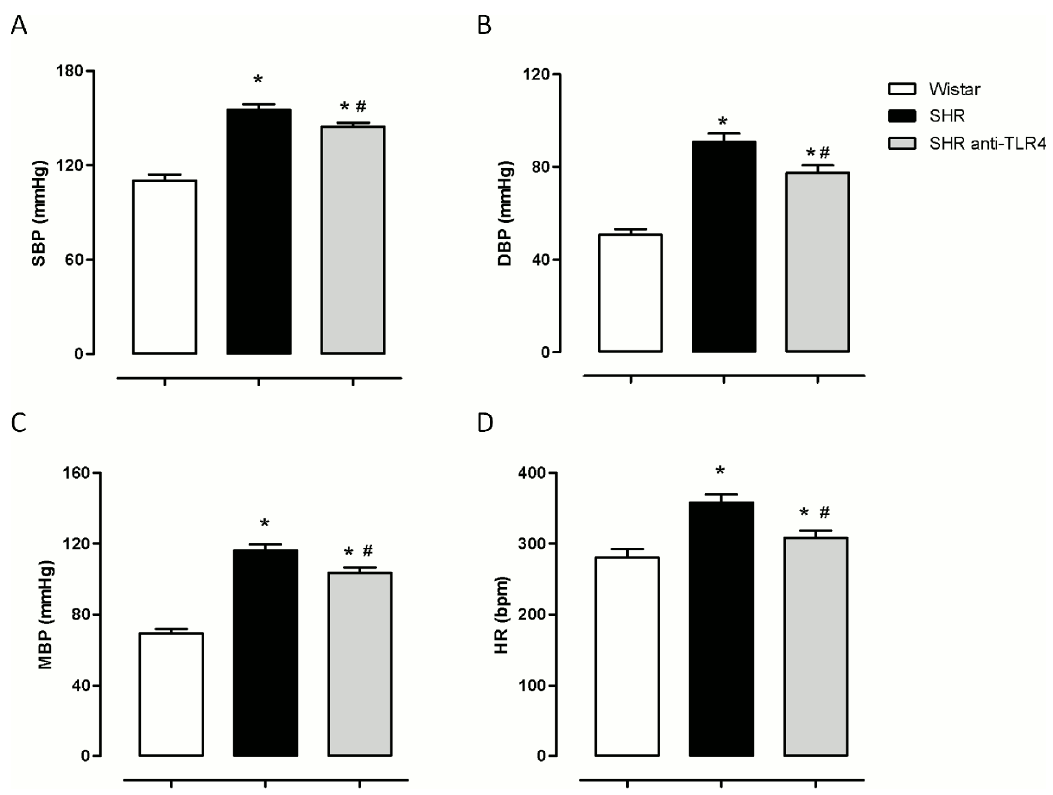
Figure 2. TLR4 inhibition reduces blood pressure and heart rate in hypertensive rats. (A) Systolic blood pressure (SBP), (B) diastolic blood pressure (DBP), (C) mean blood pressure (MBP) and (D) heart rate (HR) in Wistar and SHRs treated with a non-specific IgG (1 m g/day, 15 days) and SHRs treated with anti-TLR4 antibody (1 m g/day, 15 days). The results represent the mean 6 SEM. *P , 0.05 vs Wistar, # P , 0.05 vs . SHR using one way ANOVA and Bonferroni post-test. n=8–9.